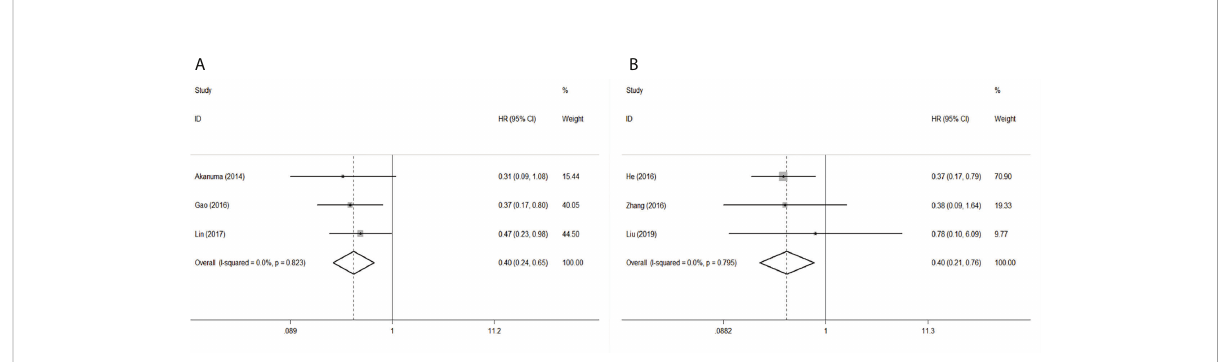
FIGURE 3 Forest plot of pooled HR of mir-133 and mir-143 in predicting survival outcomes OS in EC. (A) mir-133. (B)